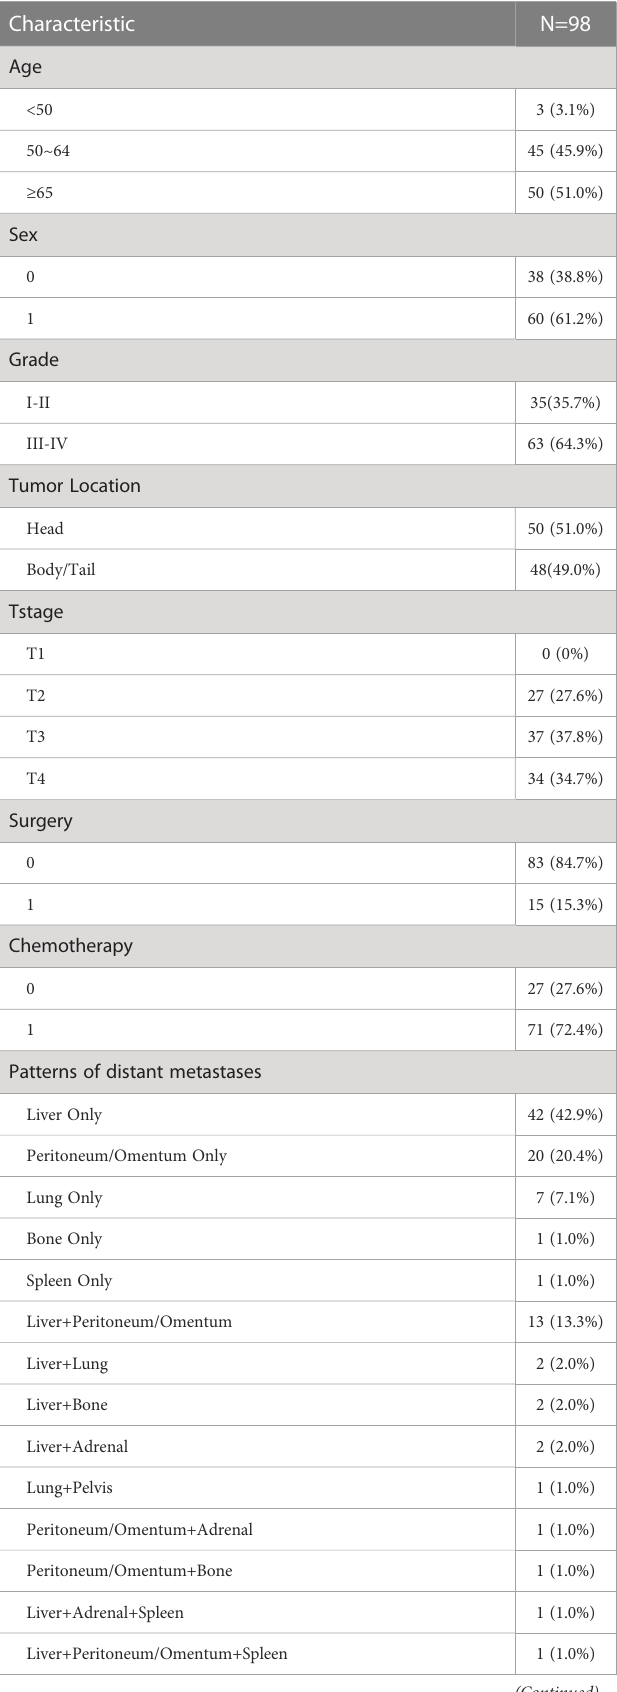
TABLE 2 Baseline clinical characteristics of 98 Chinese patients.